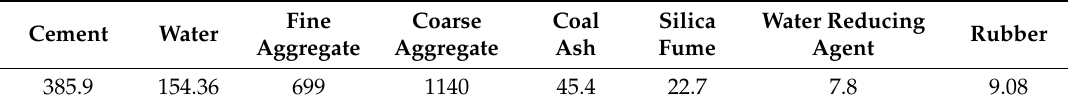
Table 1. The ratio of concrete materials (kg / m 3 ).